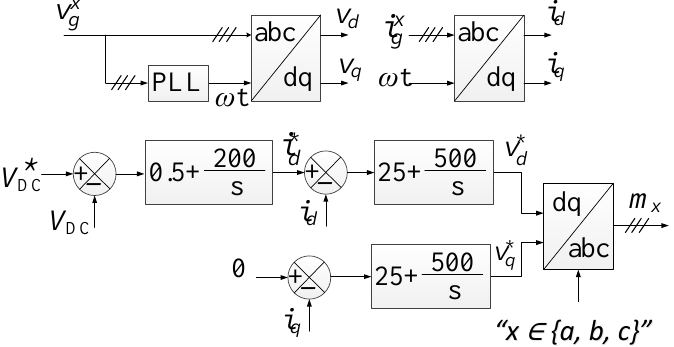
Figure 10. Generated reference signals by three-phase voltage and current controller.